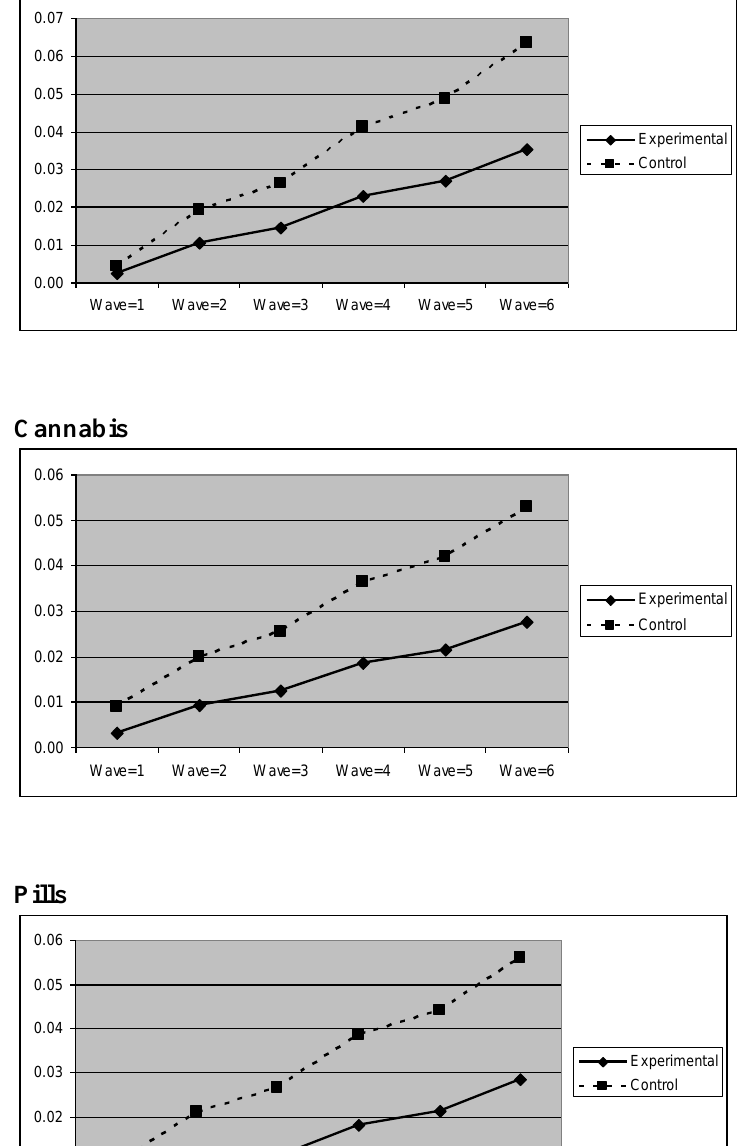
FIGURE 3 . Growth trajectories of the experimental group (participants who joined the Tier 1 Program only) and control group using the item score of taking pills as the outcome